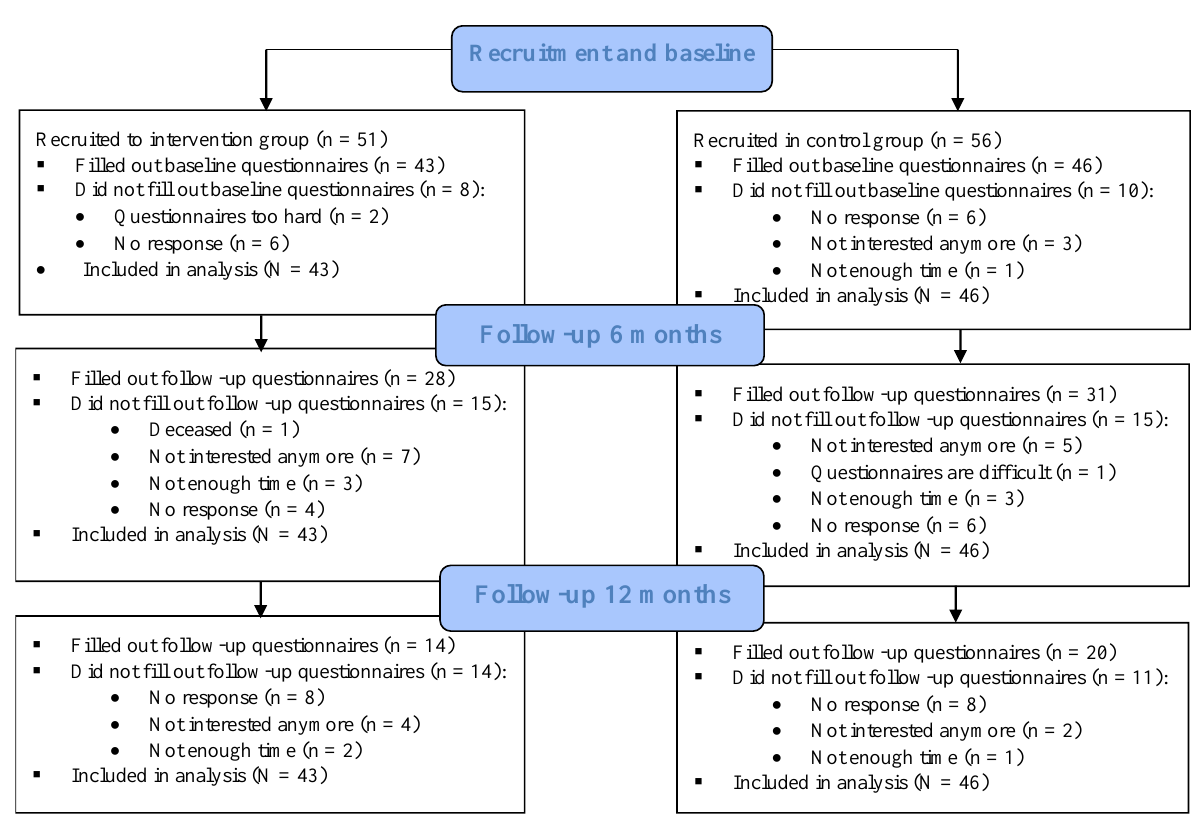
Figure 1. Flow chart of the participants.